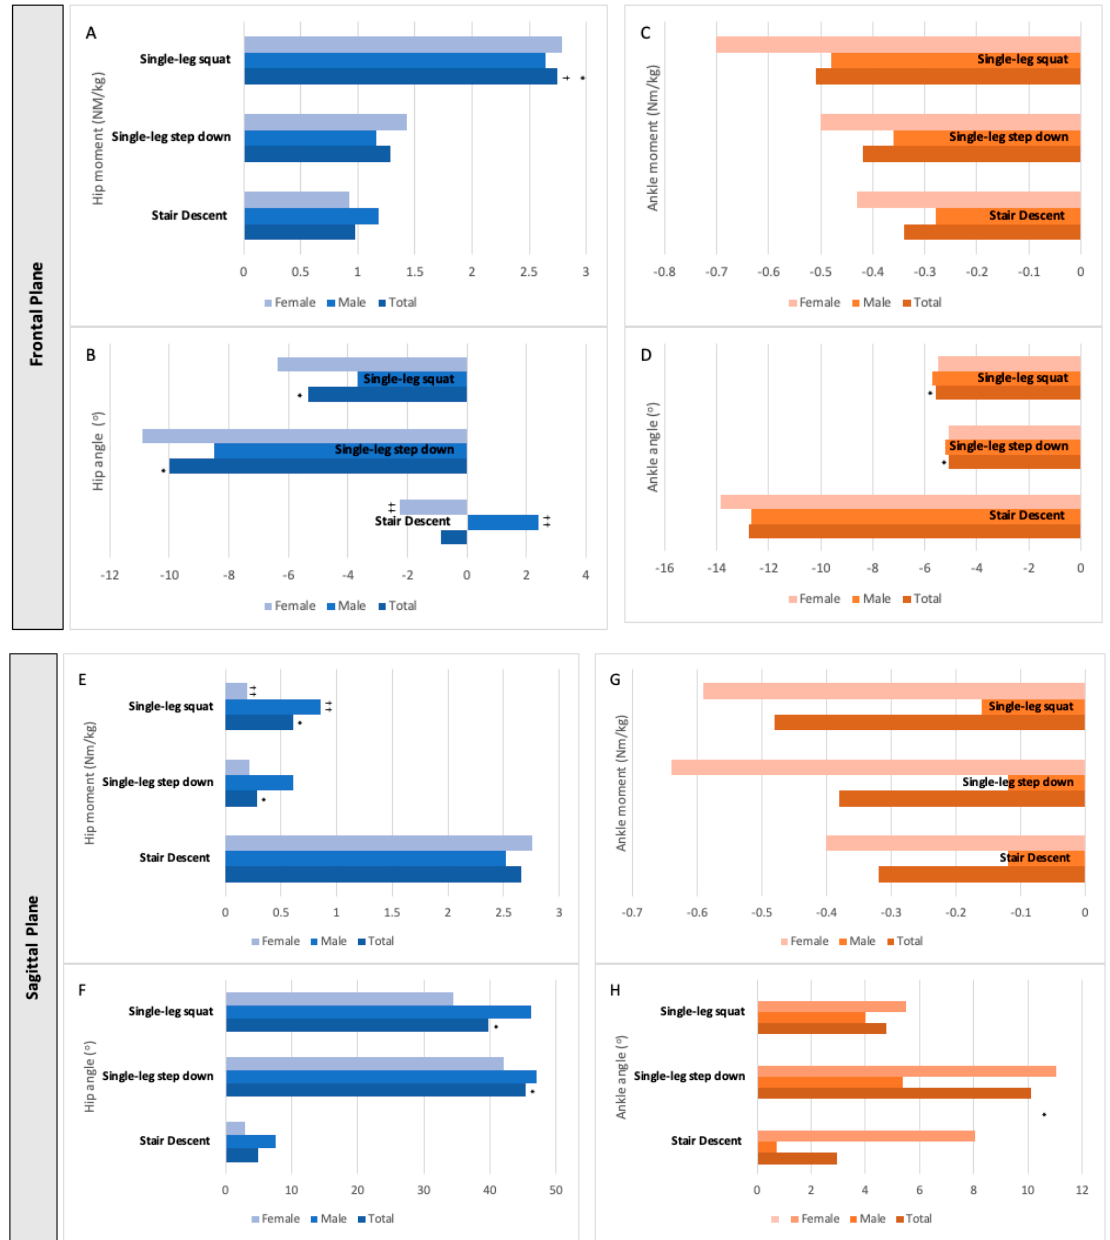
Figure 4. Adjacent joints: kinetic ( A , C , E , G ) and kinematic ( B , D , F , H ) data of the hip (blue bars) and ankle (orange bars) joints at the moment of peak knee joint moment of the total sample ( n = 30) and stratified by sex (male, n = 15; female, n = 15). Subfigures are displayed according to the plane: ( A , B ) describe the hip moment and angle at the frontal plane, ( C , D ) describe the ankle moment and angle at the frontal plane; ( E , F ) describe the hip moment and angle in the sagittal plane, ( G , H ) describe the ankle moment and angle in the sagittal plane. Note: Symbols represent in the frontal plane abduction (+) and adduction ( − ) for hip and ankle, and in the sagittal plane, hip flexion (+), extension ( − ) or dorsiflexion (+), and plantar flexion ( − ) of the ankle. * Different stair descent ( p < 0.05). † Different from single-leg step down ( p < 0.05). †† Sex difference ( p < 0.05). Sex differences were observed in adjacent joints at the peak of the knee joint moment. In the frontal plane, males presented hip abduction (+2.41), while females presented hip adduction ( − 2.27) in stair descent ( p = 0.003). In the sagittal plane, females had a higher plantar flexor moment ( − 0.59) in single-leg squats than males ( − 0.16) ( p = 0.04) (Figure